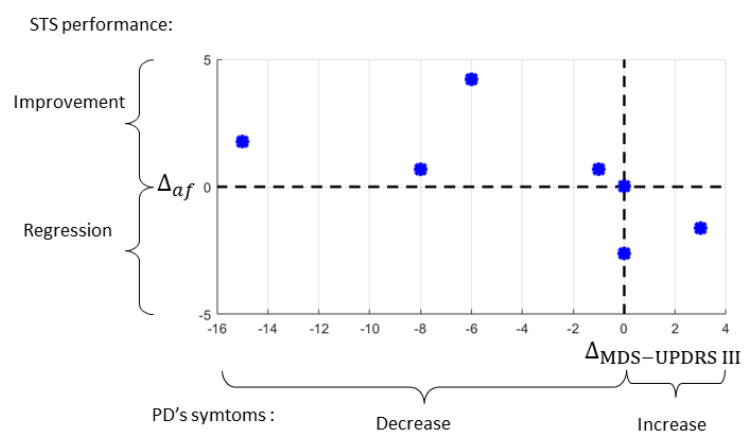
Figure 4. Variation of MDS-UPDRS III score vs. the gradient Δ 𝑎𝑓 plane.